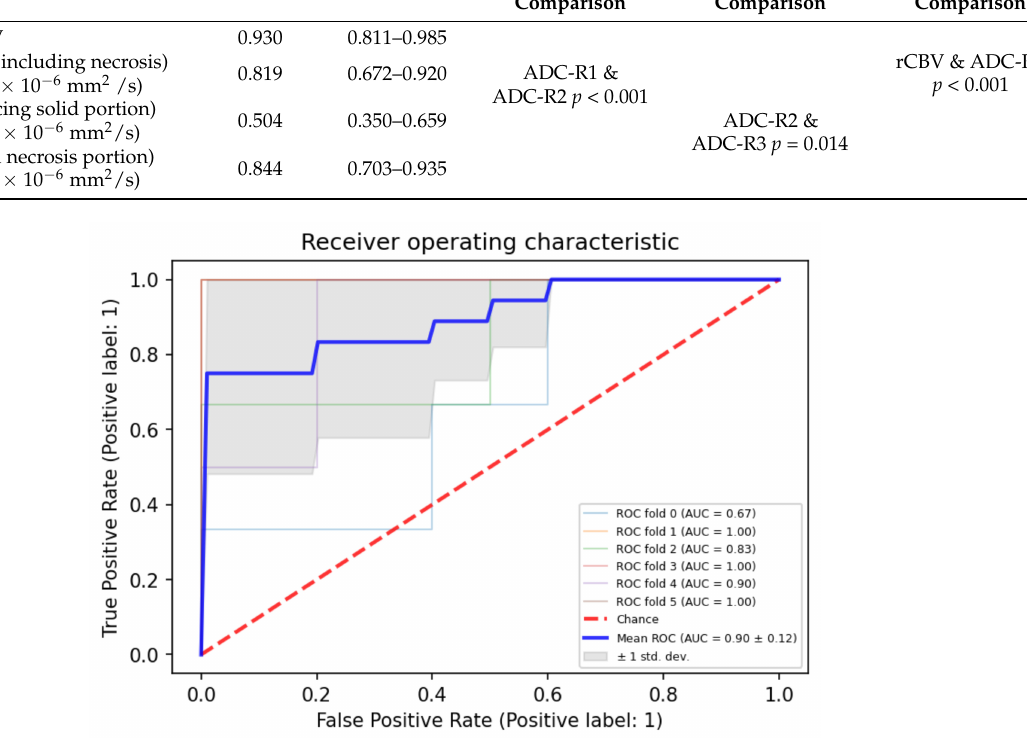
Figure 3. ROC curve of 5-fold cross validation tests for enhancers. (variance around mean curve is represented with gray shade representing confidence